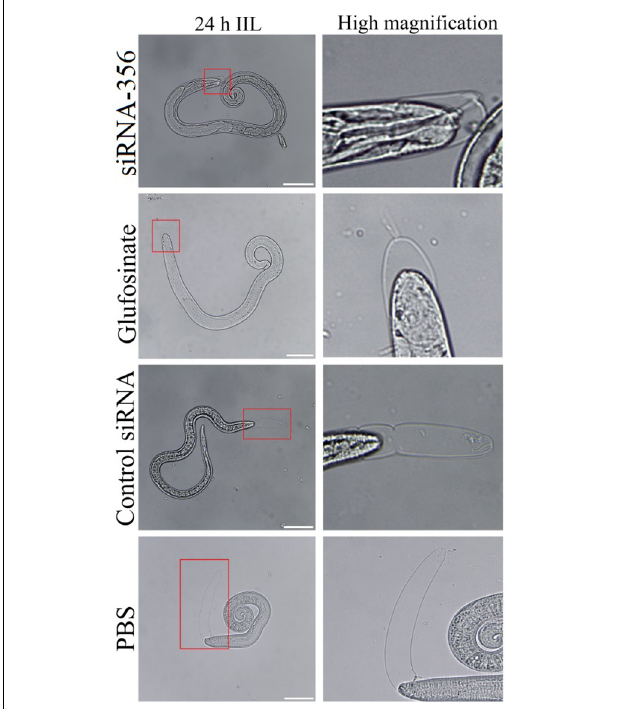
FIGURE 12 | The larval molting was suppressed by siRNA-356. In the 24-h intestinal infectious larvae (IIL) stage, the obvious suppression of larval molting was also observed in siRNA-356 and inhibitor glufosinate group. The area in the red box was magnified for observation. Scale bars = 50 µ m.